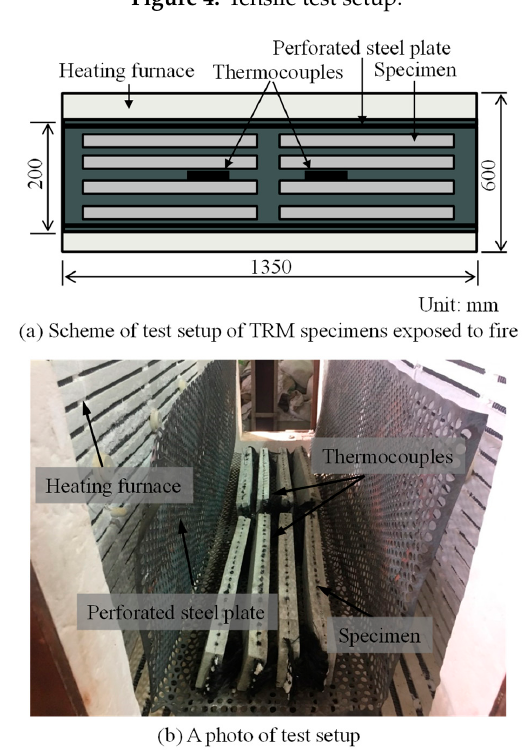
Figure 4. Tensile test setup.